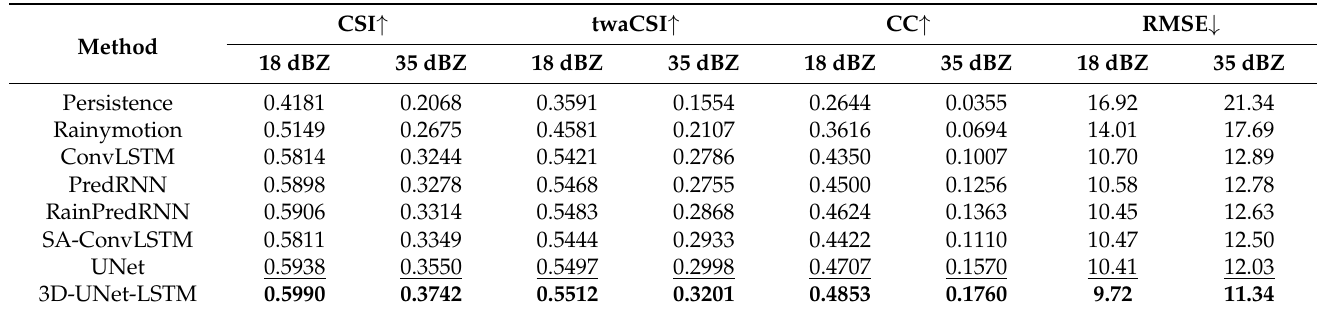
Table 2. Overall performance of the eight models on the test set.